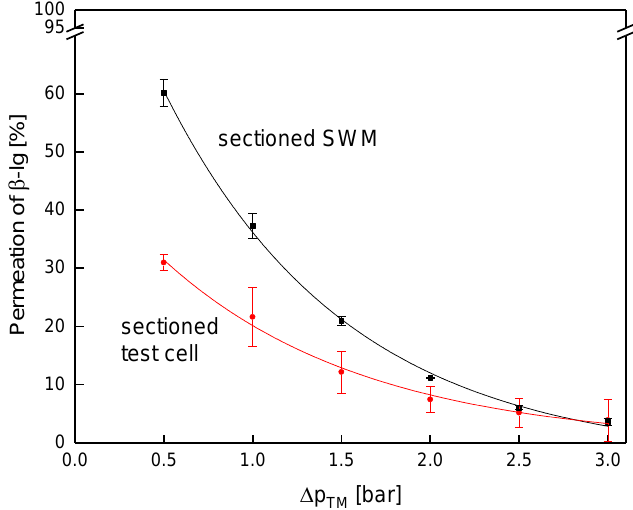
Figure 14. Protein permeation in the test cell (channel length of 1.00 m) and the sectioned membrane (length of 0.96 m) at a mean crossflow velocity of 0.42 m s − 1 .